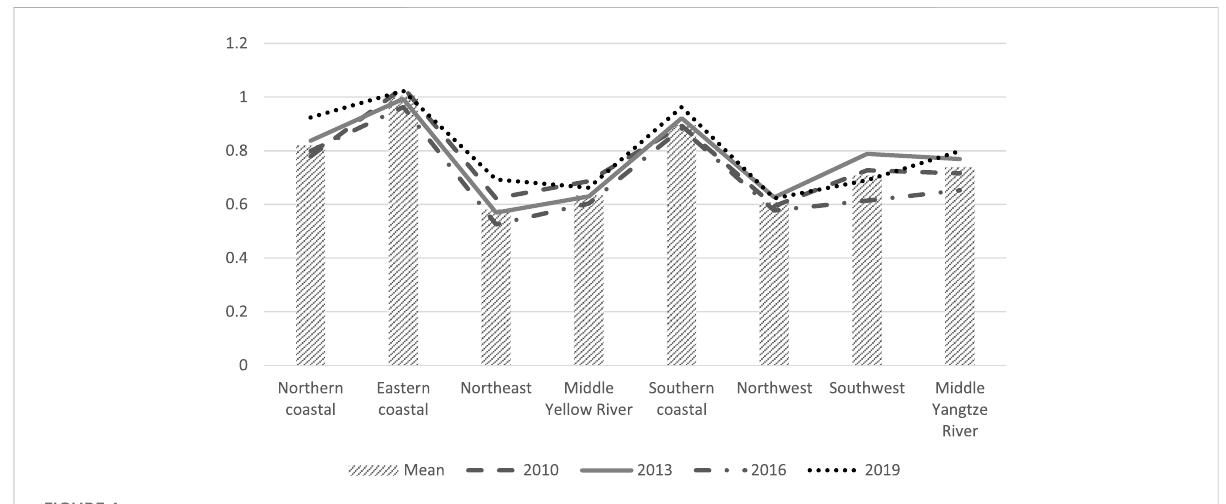
FIGURE 1 Carbon emission ef fi ciency values of public buildings in China ’ s eight economic zones.